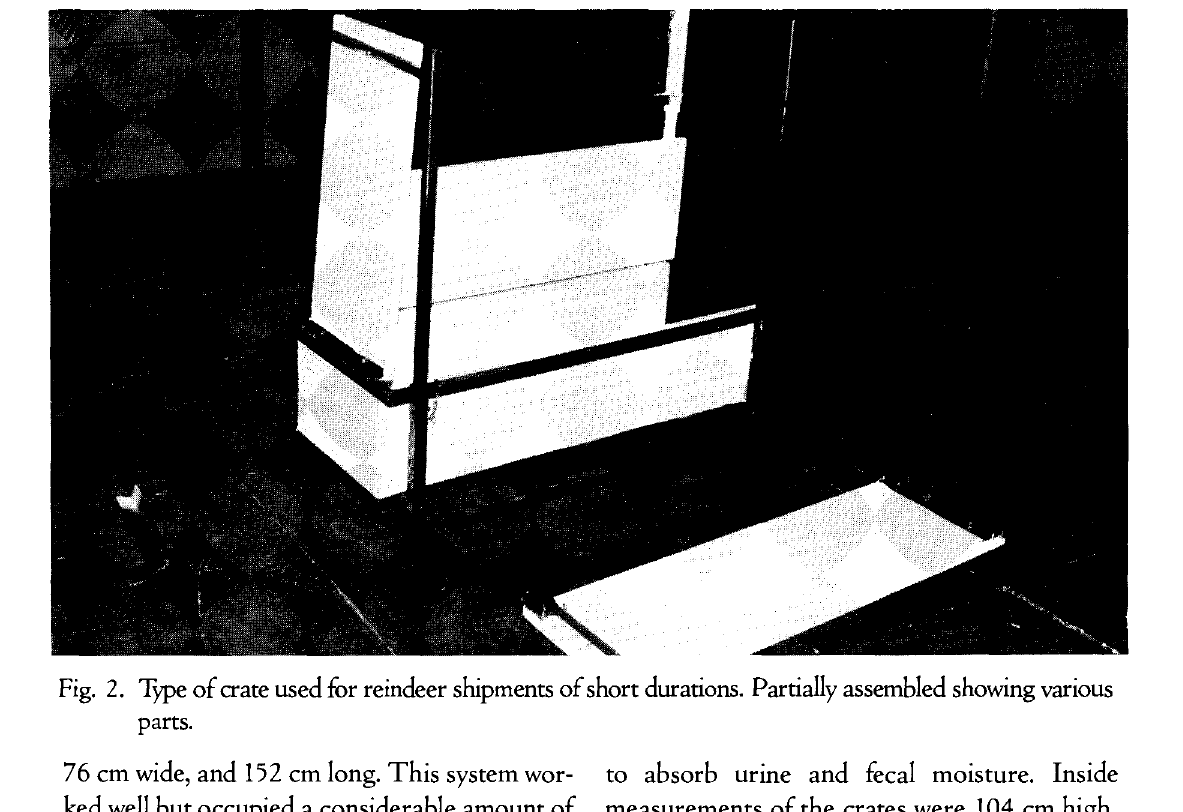
Fig. 2. Type of crate used for reindeer shipments of short durations. Partially assembled showing various